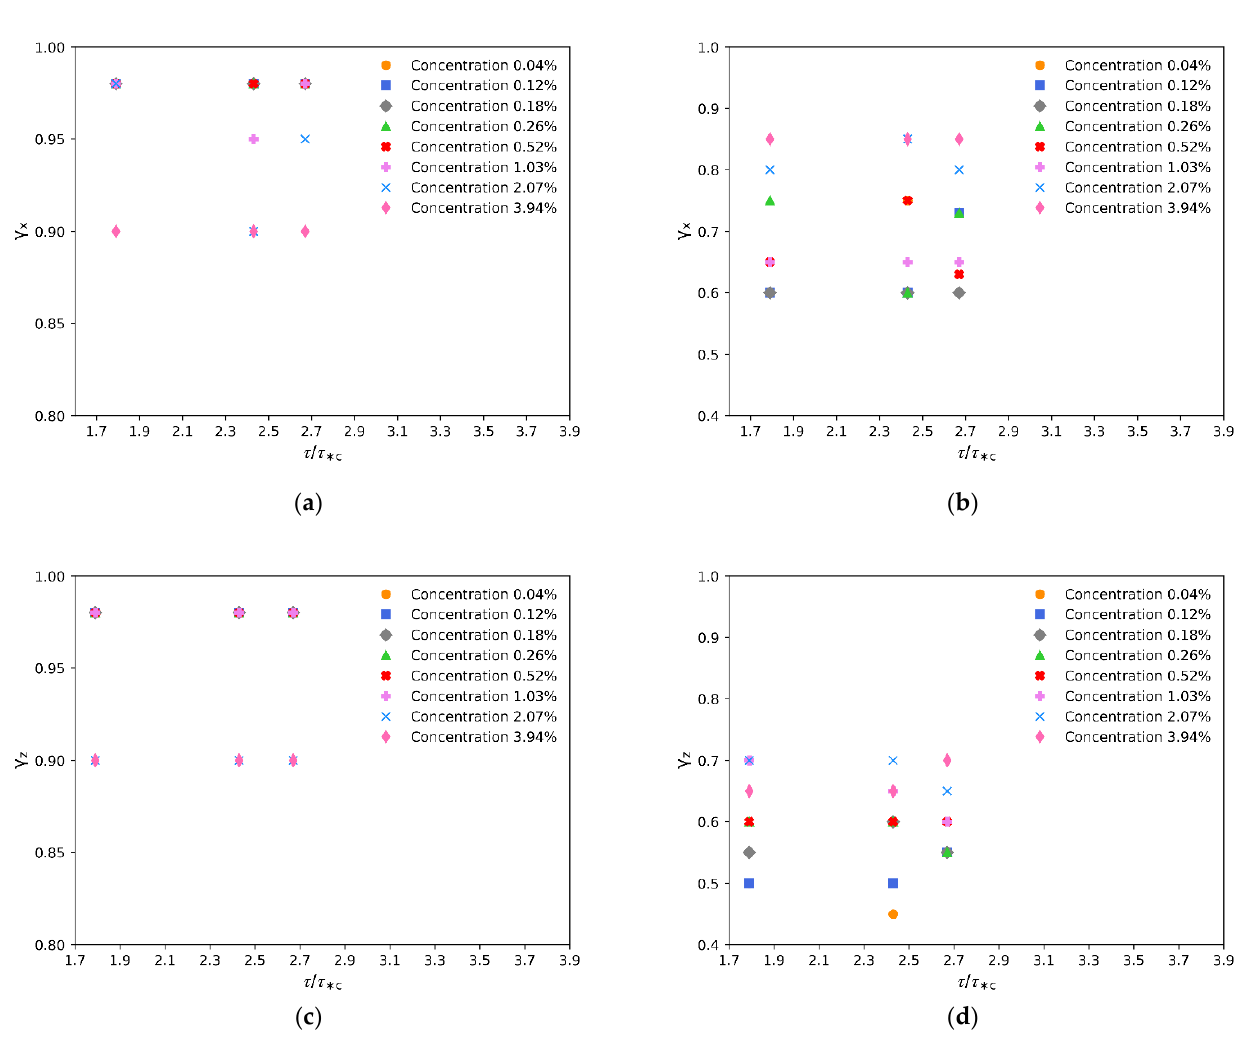
Flow Intensity ( τ * / τ * c